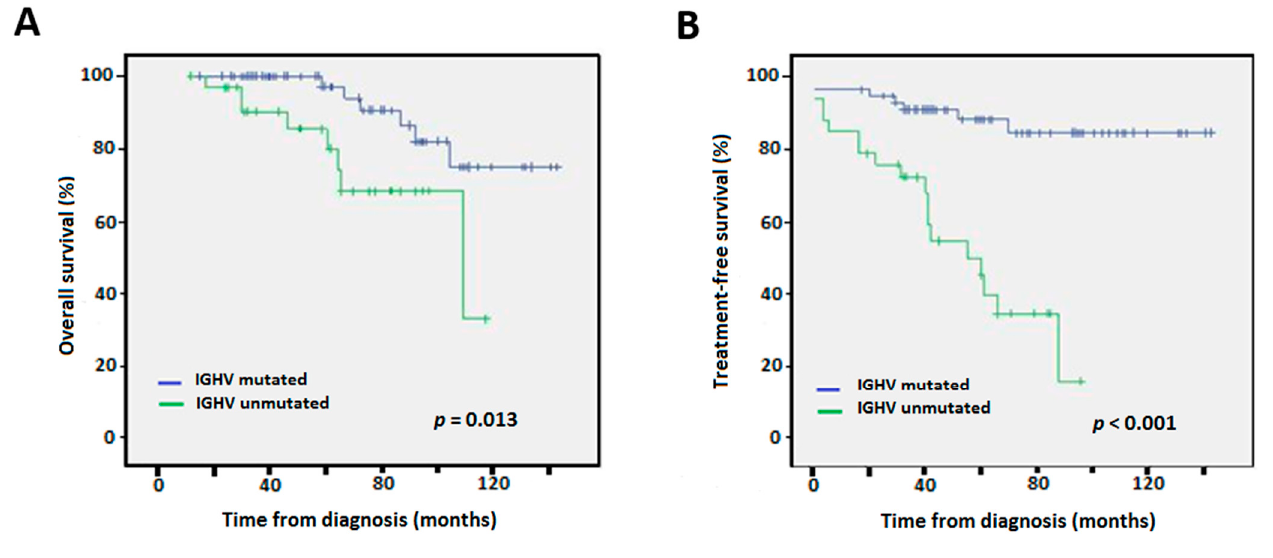
Figure 4. Kaplan-Meier survival curves according to IGHV mutational status for Rai stages 0–2 for ( A ) overall survival, and ( B ) time to first treatment.